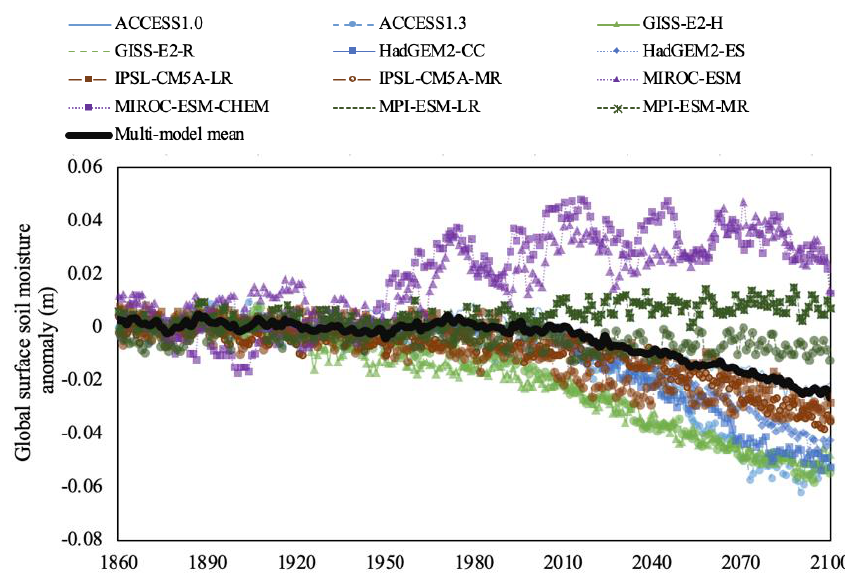
Figure 4. Anomaly of global land surface soil moisture (upper 10 cm) across the CMIP5 simulations from past to future. The results between 2006 and 2100 were obtained from the RCP8.5 scenario.